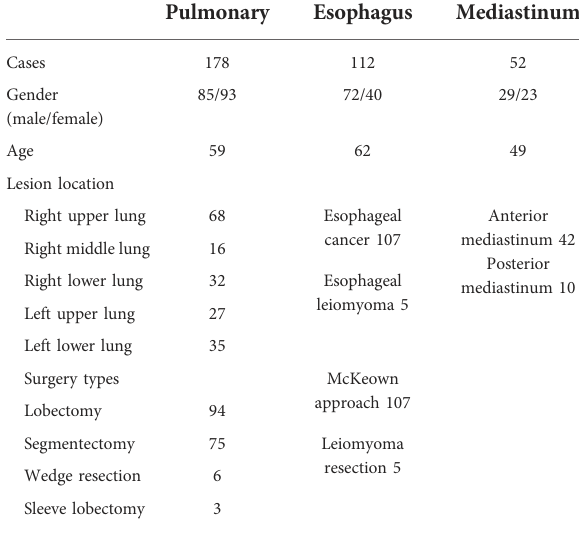
TABLE 1 The general characteristics of 342